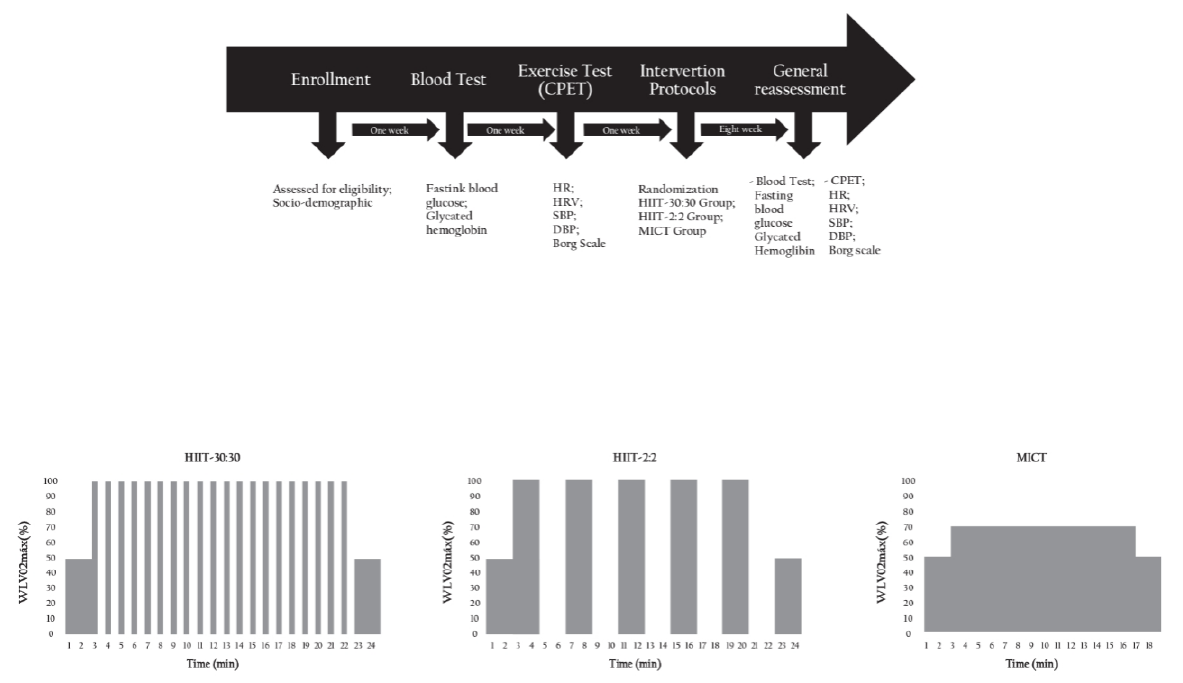
Figure 2. Study design. HR: heart rate; HRV: heart rate variability; SBP: systolic blood pressure; DBP: diastolic blood pressure.